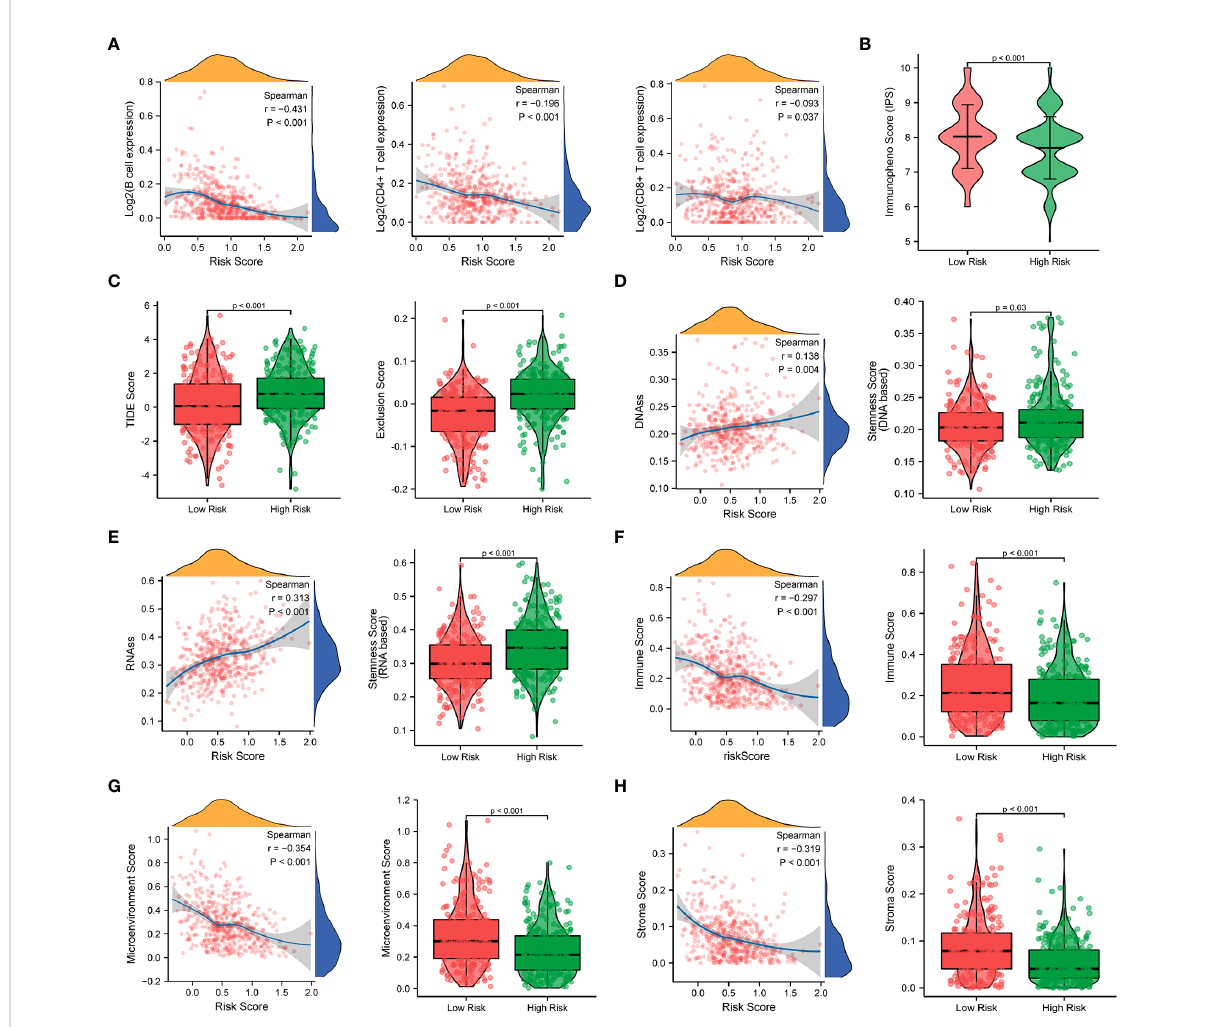
FIGURE 10 Correlation analysis of the prognostic signature and immune in fi ltration in LUAD patients. (A) Correlation analysis of the risk score and immune in fi ltration via The Tumor Immune Estimation Resource (TIMER, http://timer.cistrome.org/) database. (B, C) Comparison of the IPS score (B) and the TIDE score (C) between the high-risk and low-risk groups. (D – H) Correlations between risk score and DNA methylation-based stemness score (D) , RNA-based stemness score (E) , immune score (F) , microenvironment score (G) , and stroma score (H) , and the comparison of various scores between the high-risk and low-risk